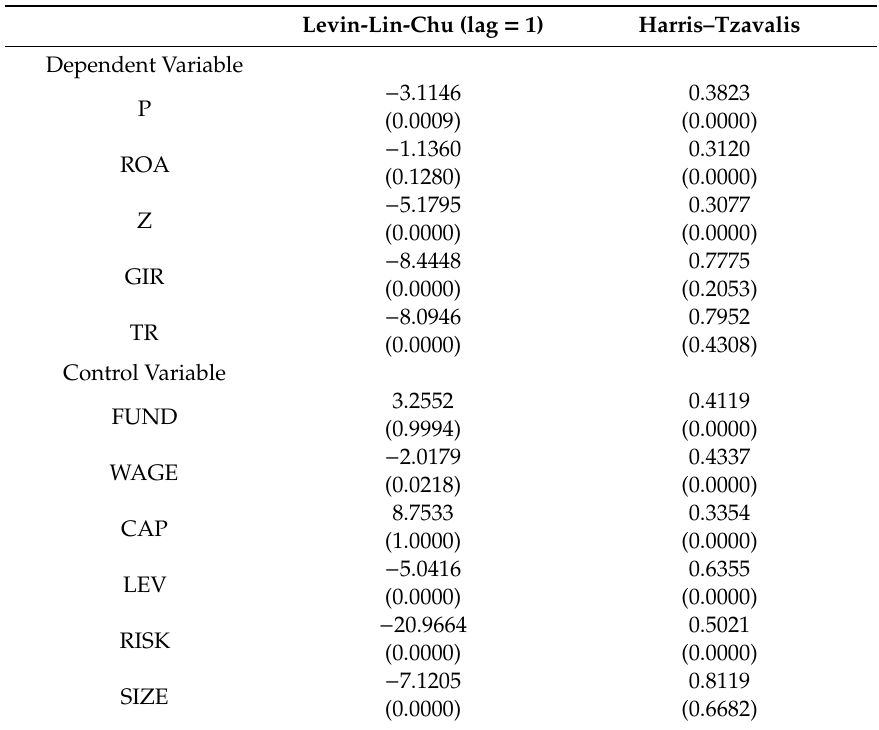
Table A3. Panel unit root test results. ( A ) ALL BANKS; ( B ) PUBLIC BANKS; ( C ) PRIVATE BANKS; ( D ) FOREIGN